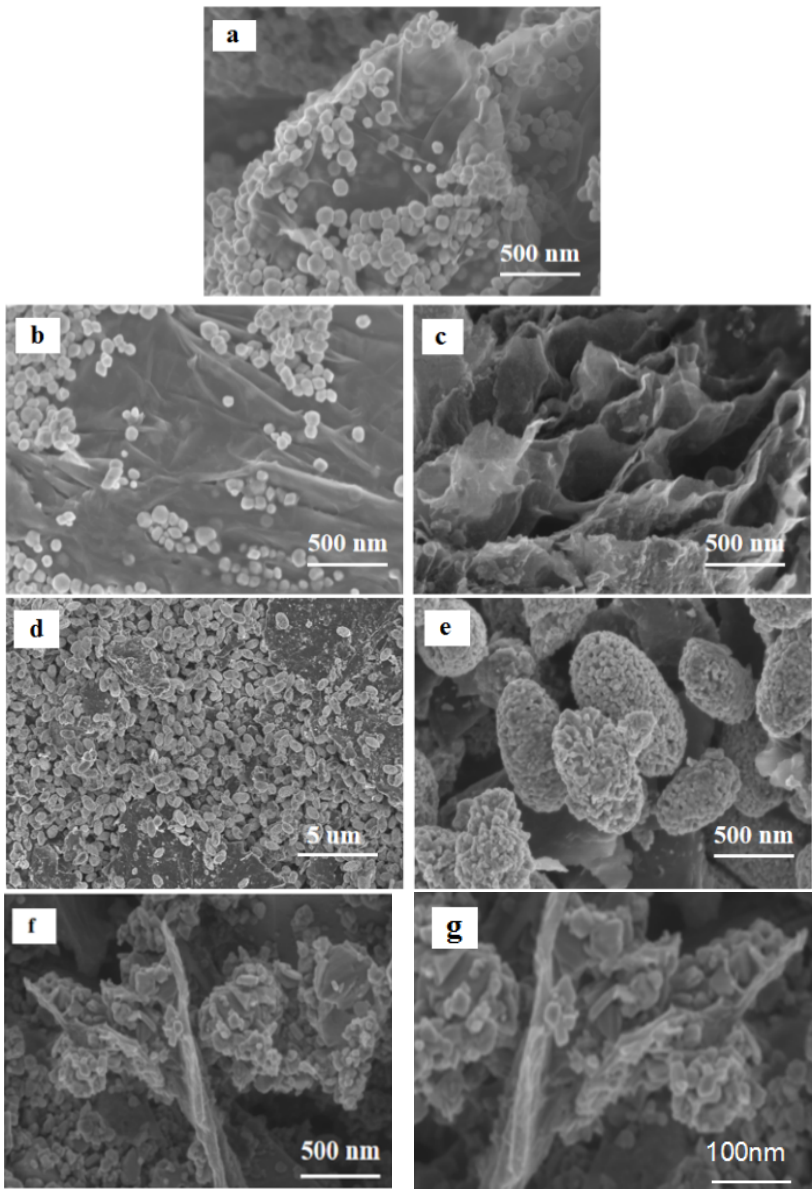
Figure 3: SEM morphology images of Fe 2 O 3 /rGO composites prepared by different hydrothermal in-situ methods (a-c) hydrothermal in-situ method; (d-e) PVP-assisted hydrothermal in-situ method; (f-g) oleic acid-assisted hydrothermal in-situ